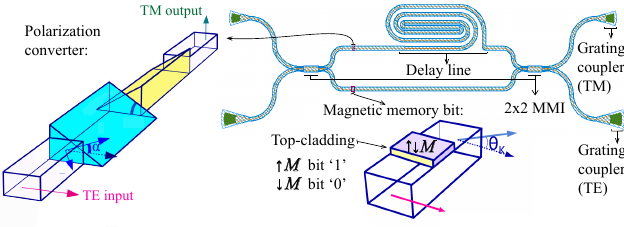
Figure 1. An unbalanced MZI. TE and TM mode selective grating couplers are used to couple the light in and out. The polarization converter is taken from [26].